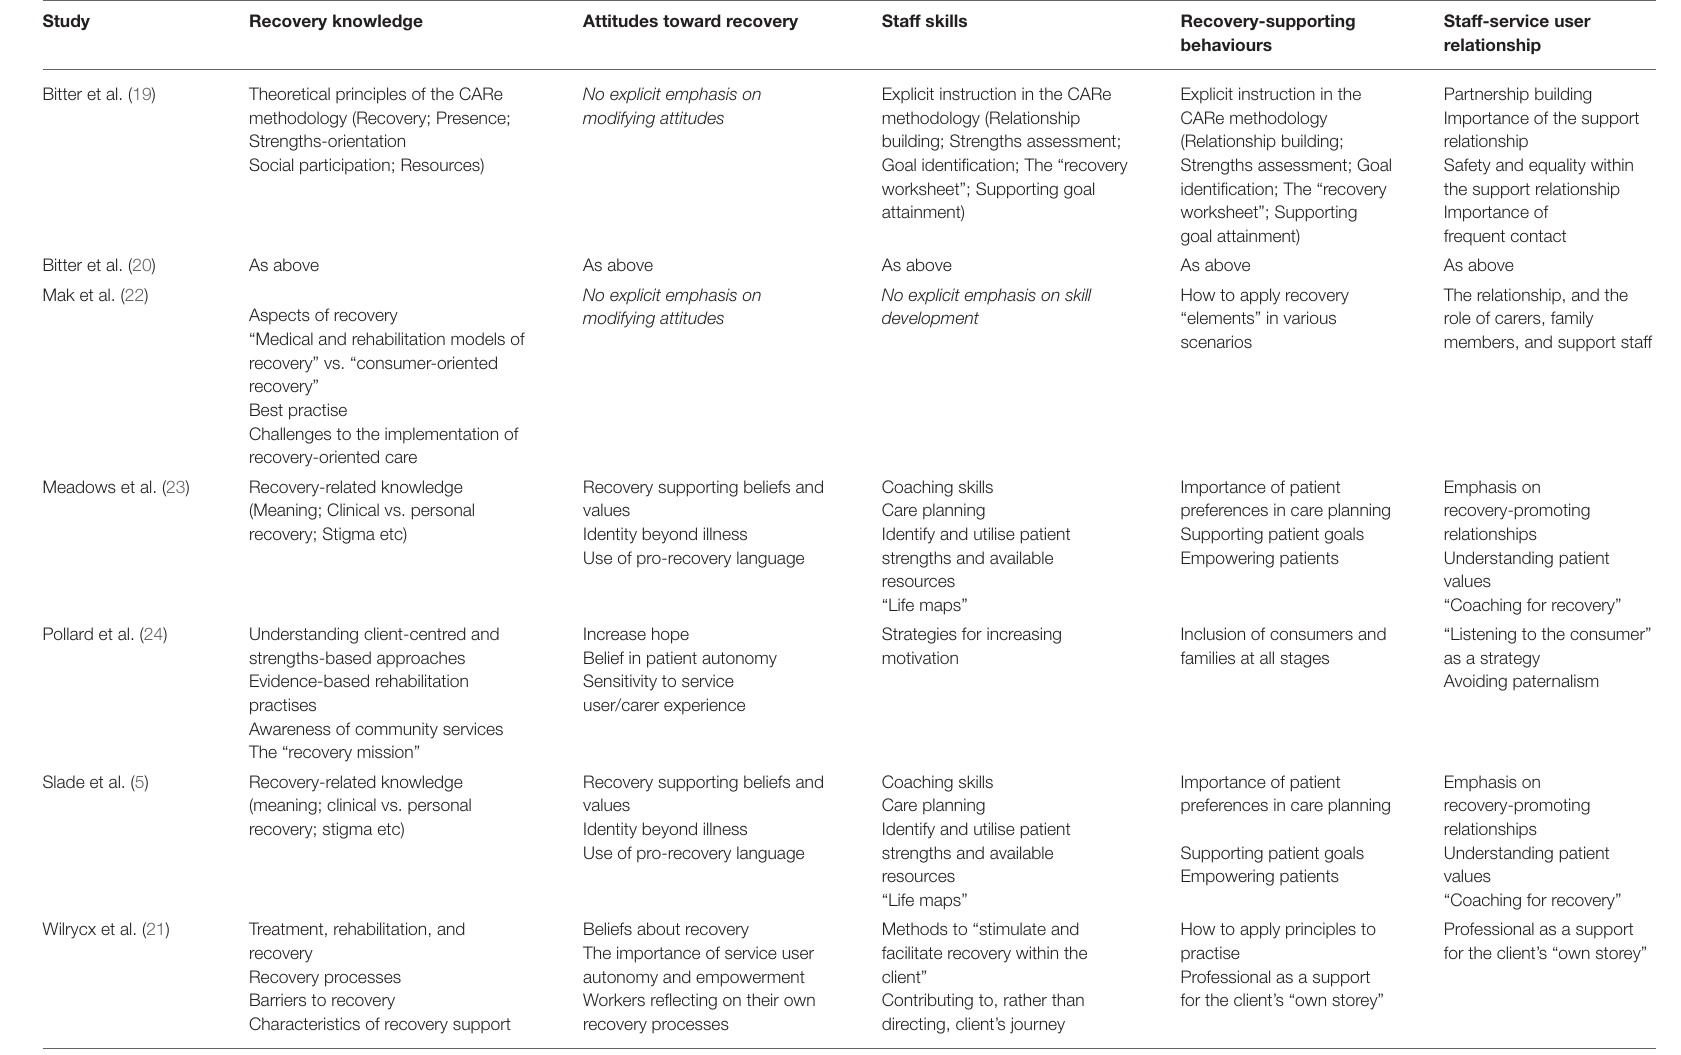
TABLE 3 | Training content of the included